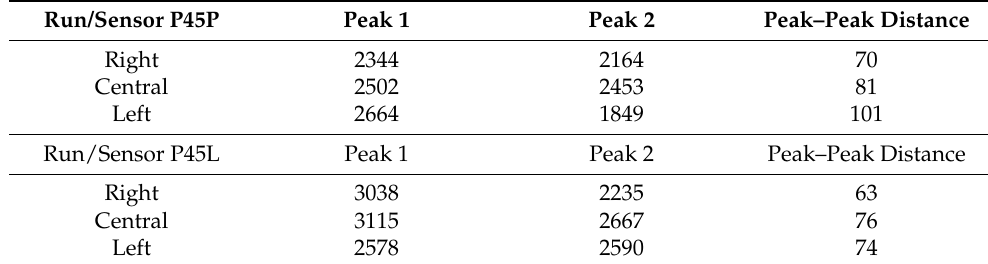
Figure 16. Example of signals from the piezoelectric sensors for right- and left-side run and in lane alignment—the second axis of the five-axle vehicle. Table 6. Piezoelectric sensor signal characteristics—amplitude (ADU) and Peak–Peak separation distance (samples) for a twin wheel.